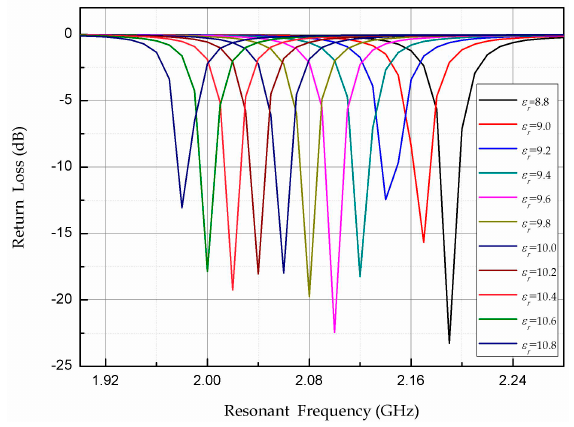
Figure 3. Simulated S 11 curves of the sensor for different dielectric constants of the aluminum nitride (AlN) ceramic material.